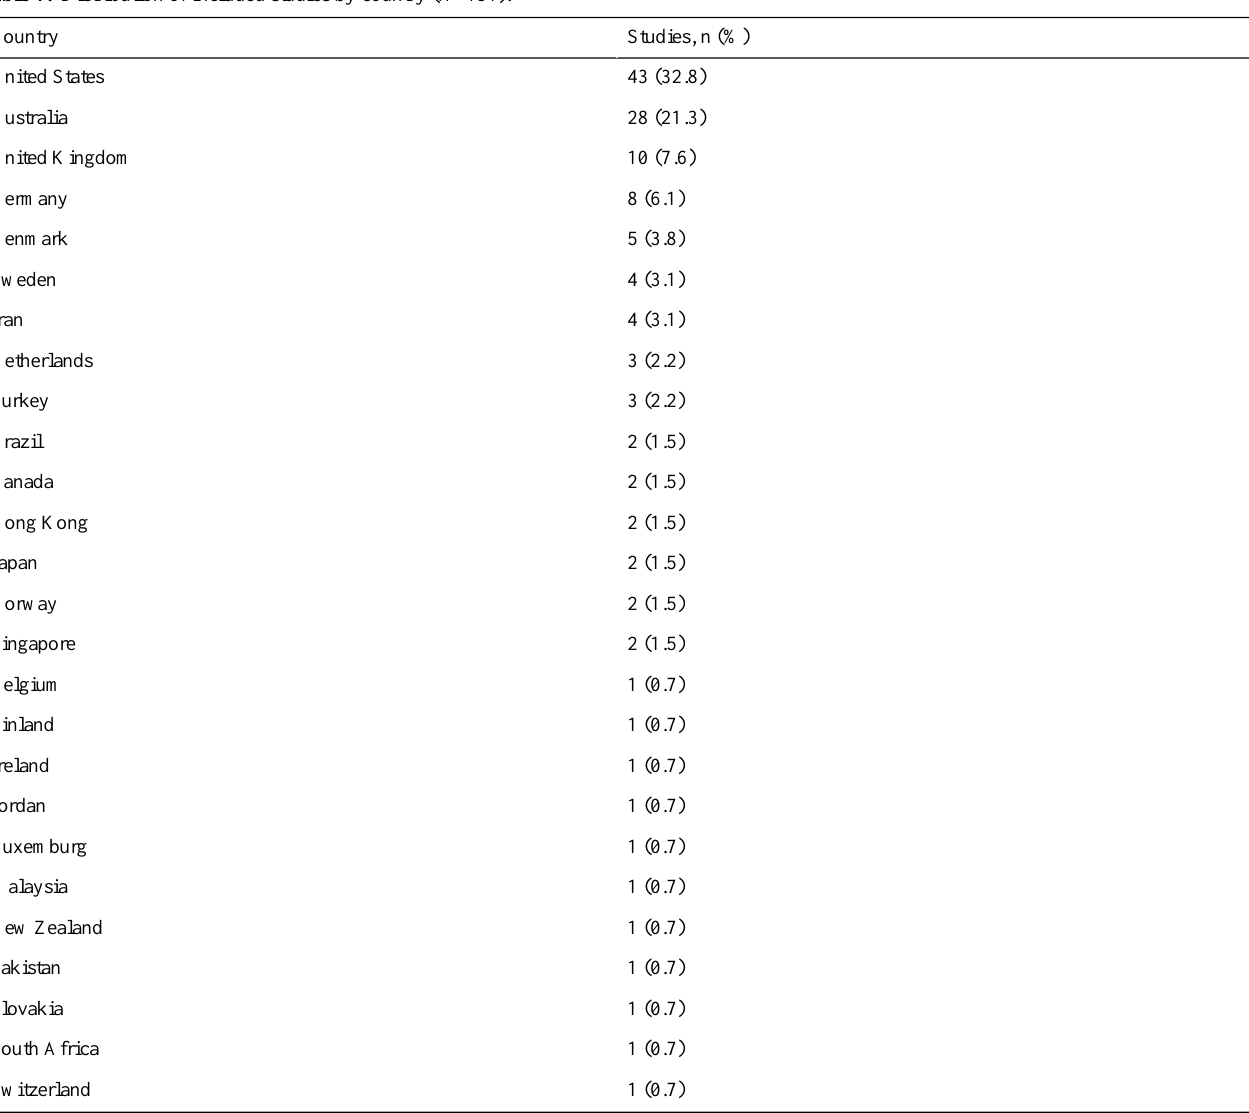
Table 1. Distribution of included studies by country